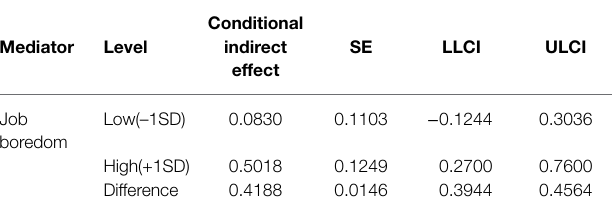
TABLE 5 | Moderated mediated results for POQ and CWB across levels of job